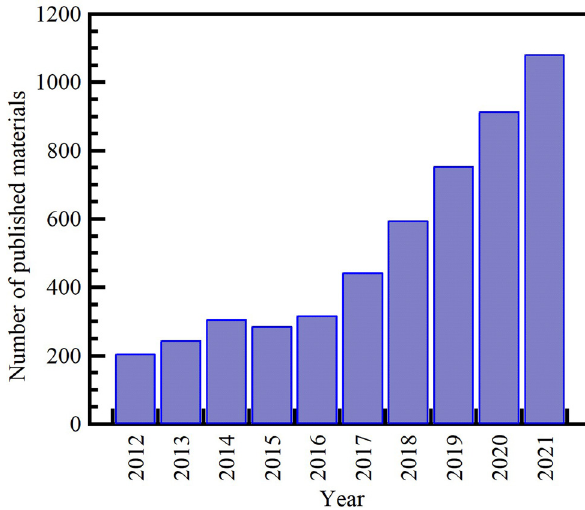
Figure 37: Publication distribution about waste recycled into bat - teries ( or battery recycling )